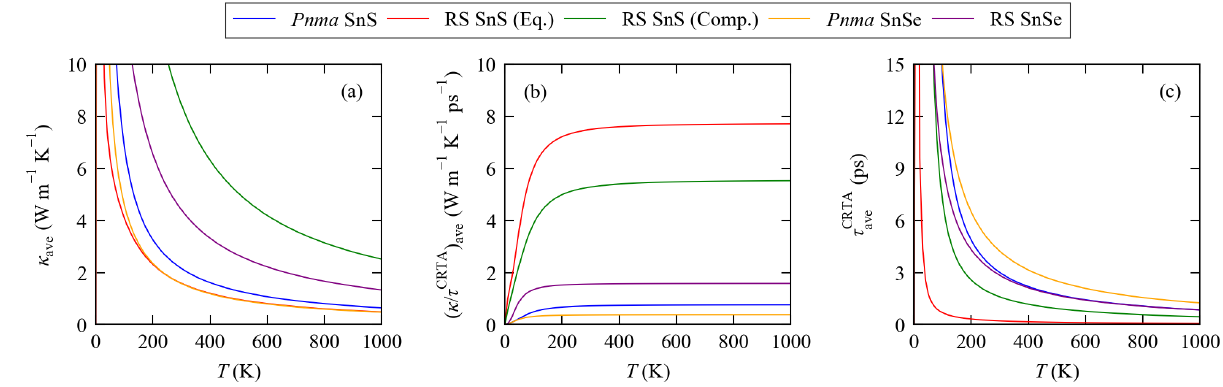
Figure 7. Analysis of the lattice thermal conductivity κ latt of the five structures examined in this work using the constant relaxation time approximation (CRTA) model defined in Equation (18). The three subplots compare the κ latt ( a ) to the harmonic term κ / τ CRTA ( b ) and the weighted average lifetime τ CRTA ( c ) as a function of temperature. For the two Pnma phases, we analyse the averaged κ latt computed using Equation